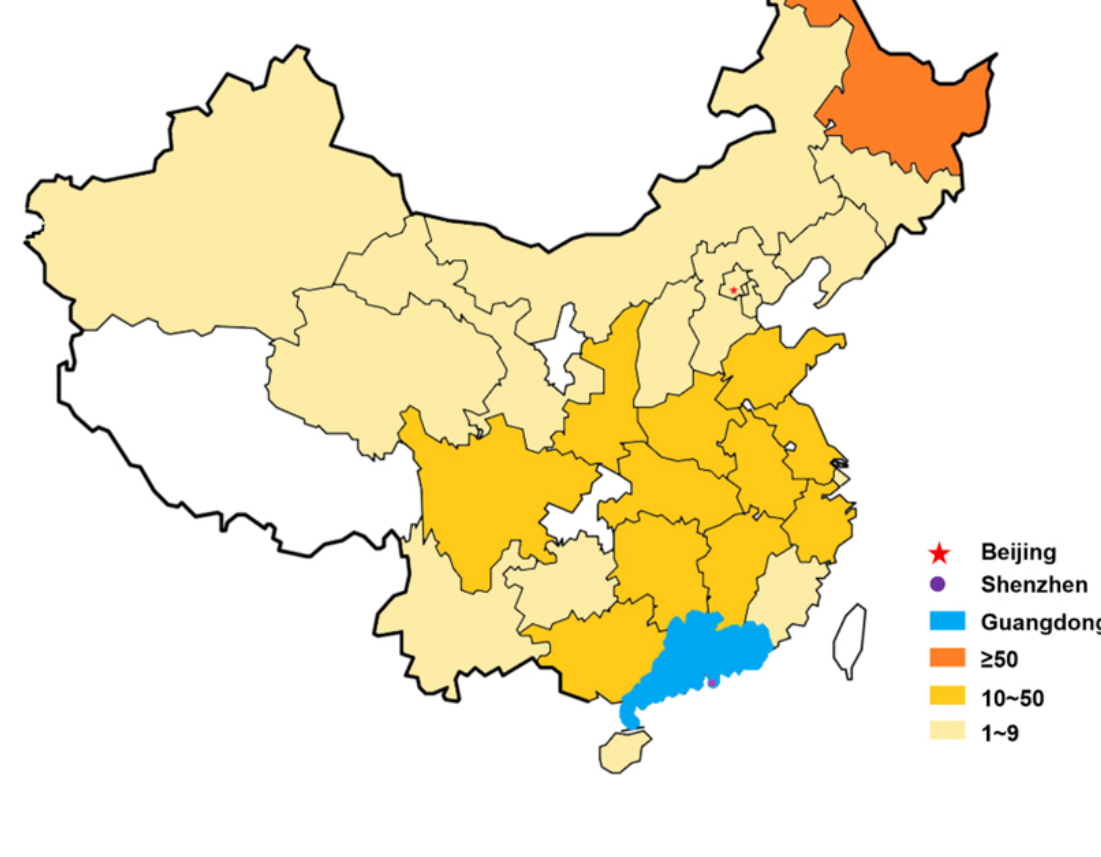
Figure 3. Regional distribution of prescription